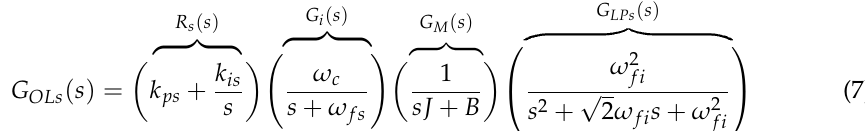
(8) Based on Equation (7) and Equation (8) the current and voltage control loops of the DAB converter were tuned. 4. Experimental Results Each sub-system, parts of the charging station, is accurately tested before any inte- gration takes place. The switching frequency f sw of the 3 Φ 5L E-Type Inverter and Rectifier is set at 20 kHz, while the switching frequency f sw of the DAB is set at 40 kHz. The dead- time DT of the converters is set at 2 μ s. Figure 15 and Figure 16 show the grid-tied con- verter waveforms when fully connected to the grid. The very low distortion related to the